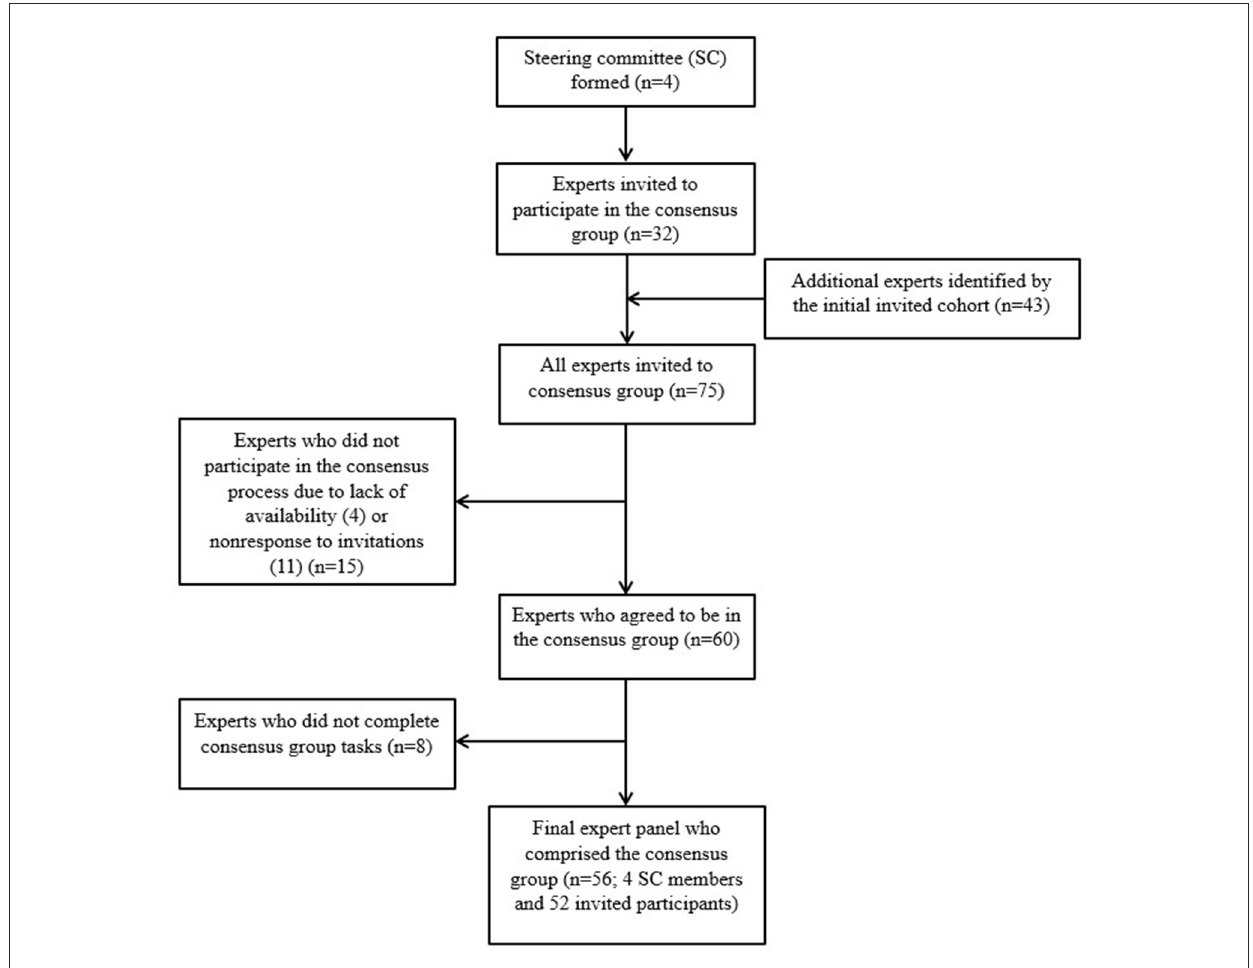
FIGURE1 Consensus group participant flow chart during creation of the expert